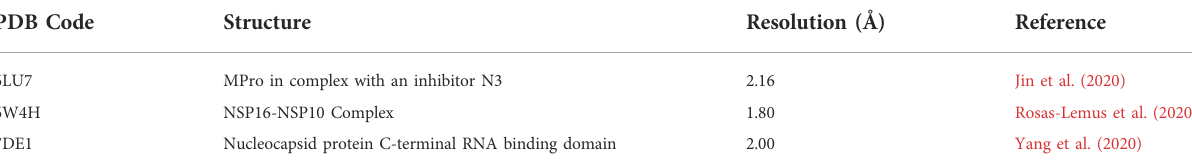
TABLE 1 Selected SARS-COV-2 protein structures retrieved from the